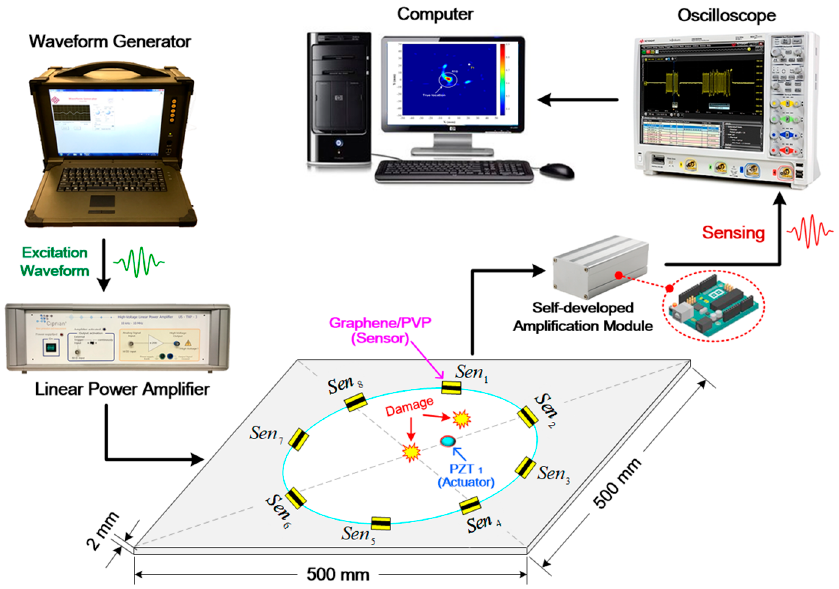
Figure 7. Schematic of the experimental set-up.